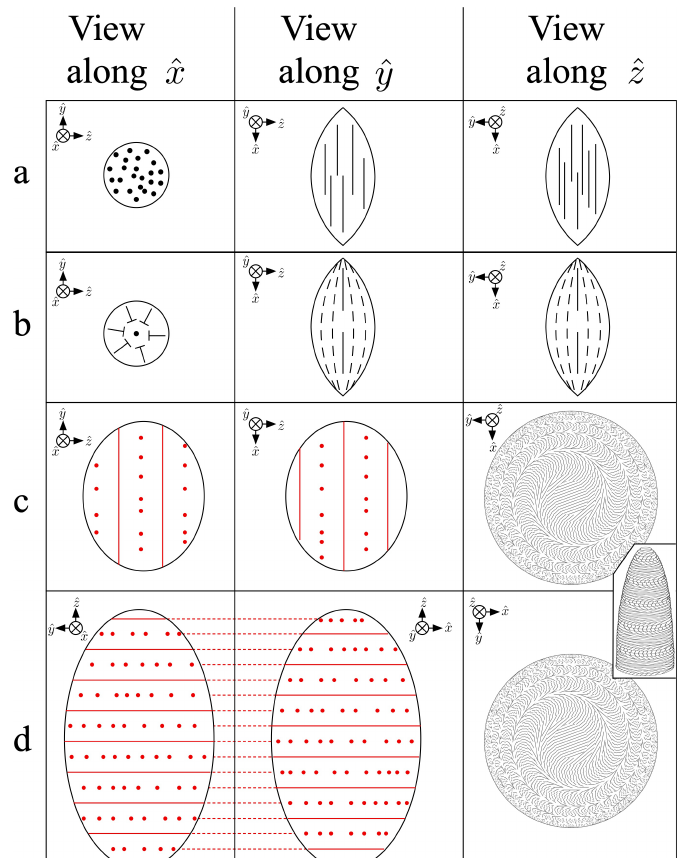
Figure 7. A schematic overview of tactoids of increasing size, from top to bottom, developing in a cholesteric-forming colloidal nanorod suspension. Each tactoid type (one per row) is sketched as it is viewed along ˆ x , ˆ y and ˆ z (see local coordinate systems for guidance), where we define ˆ z = m as the orientation of the helix when it develops. The drawings do not represent cross sections, but the projection into the paper plane of the outer tactoid surface. We sketch the director field in black and for the helix we draw side views in the first two columns, indicating n in the figure plane with red lines and n perpendicular to this plane with red dots, thus with a rotation of n by 90 ◦ in-between. Row ( a ) depicts the smallest tactoid (rarely seen in CNC suspensions), in which the director field is uniform, violating the anchoring conditions. The next row shows a tactoid of slightly larger size, where the anchoring condition is respected, a director field with bend and splay deformations developing within the tactoid. In the view along ˆ x we use ’nails’ to illustrate the director field tilting out of the plane as a result of the surface curvature, the ’head’ of the nail pointing towards us, the ’tip’ pointing away. In row ( c ), a tactoid just large enough for the helix to develop is shown, the twisting developing from a non-helical director field that was originally pointing along ˆ x (as in rows a , b ). The final row shows the most commonly observed tactoids in CNC suspensions, where the helix has developed with many pitches, still along a single direction throughout the tactoid (orthogonal to the corresponding direction in c ), still violating the anchoring conditions. We draw the situation for an ellipsoidal shape, elongated along m , which is common once the tactoids grow to sizes of several pitch lengths. The curving director pattern along ˆ z in rows ( c ) and ( d ) is the projection of a hemispherical cap viewed along the helix. It has been created using the construction of Bouligand and Livolant [84], stacking 50 slices taken at constant z distances on top of each other, from the base to the top of the hemisphere, as illustrated in the inset between rows ( c ) and ( d ). We used 20 ◦ rotation of n from one slice to the next. Note that the views along ˆ x , ˆ y and ˆ z are correlated, to better illustrate the helical variation of the director field. Red dotted lines between the sketches emphasize this aspect in row ( d